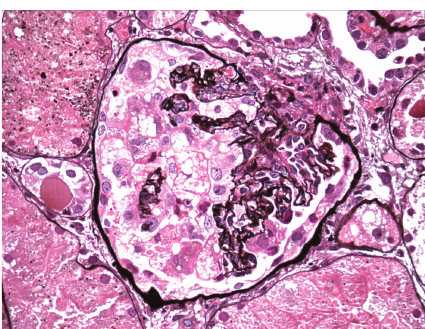
Figure 1: Light microscopy showing collapsing focal segmental glomerulosclerosis with mesangial hypercellularity and resulting collapse of the glomerular capillaries.